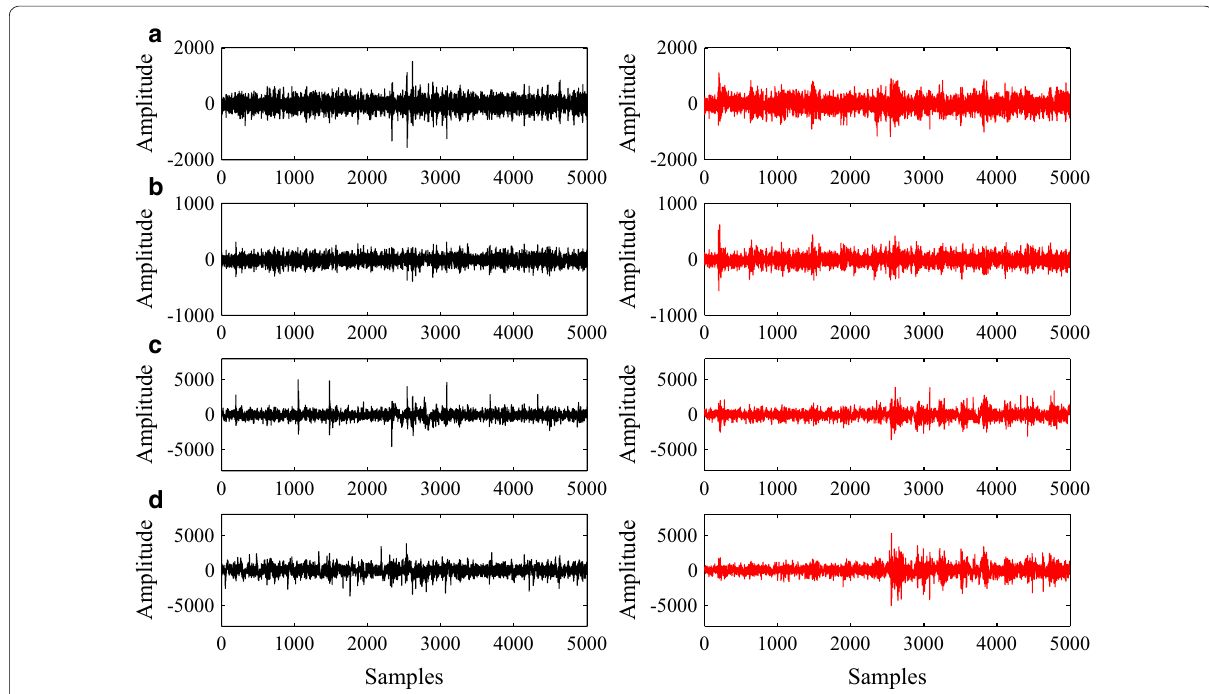
Fig. 5 De-noised time-series segments by ISISC (left) and PSO-PD (right). a Ex component; b Ey component; c Hx component; d Hy